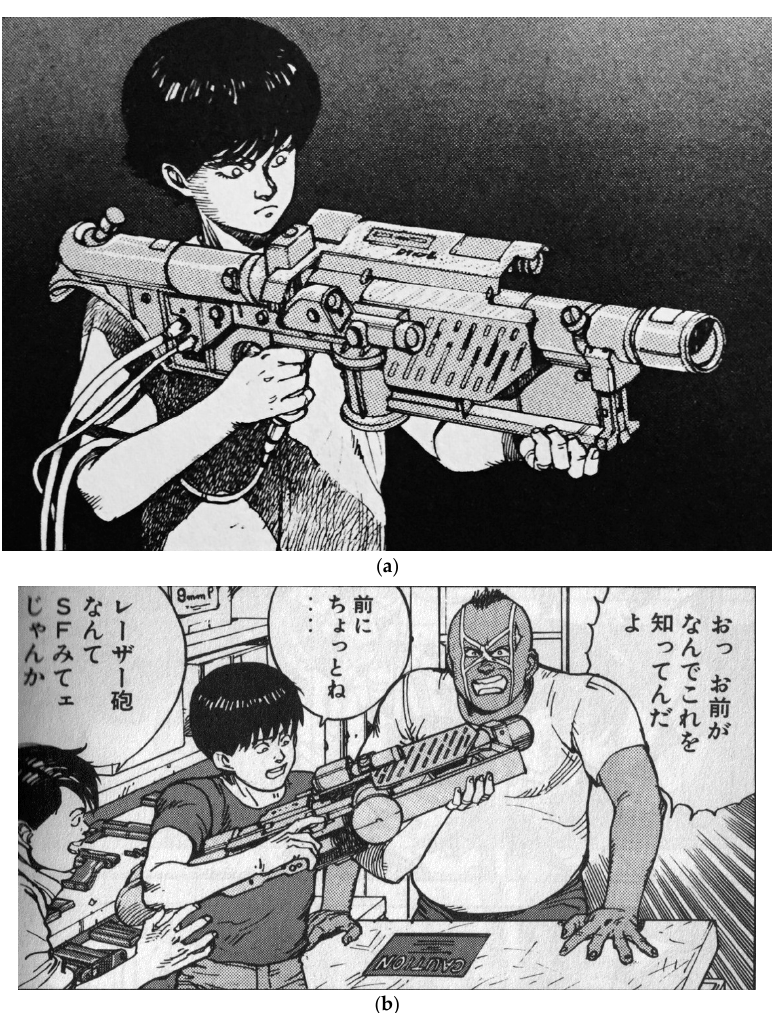
Figure 5. ( a ) panel from Katsuhiro Ō tomo, Akira (K ō dansha), vol. 2 (1985), p. 72; ( b ) vol. 5 (1990), p. 312. p.